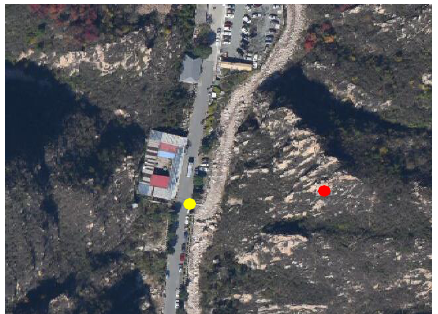
Figure 7. A closeup of the perspective projection of a ground control point